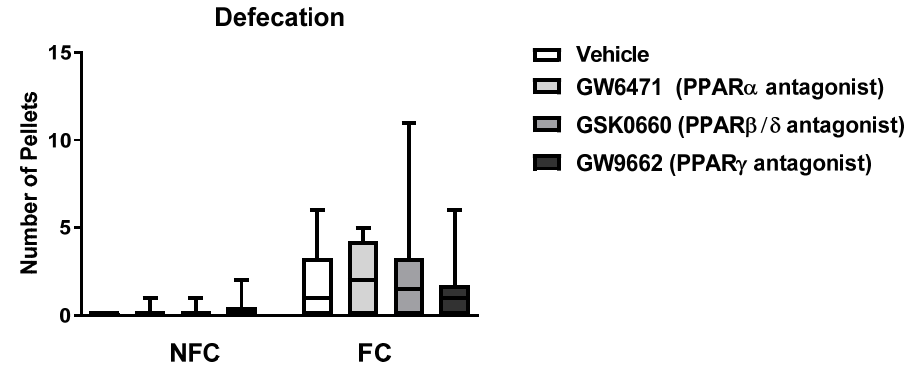
Figure 11 . Effects of fear conditioning and intra-BLA administration of selective PPAR α , PPAR β / δ , and PPAR γ antagonists on defecation. Data are expressed as median with interquartile range and min/max ( n = 7–9 rats per group).